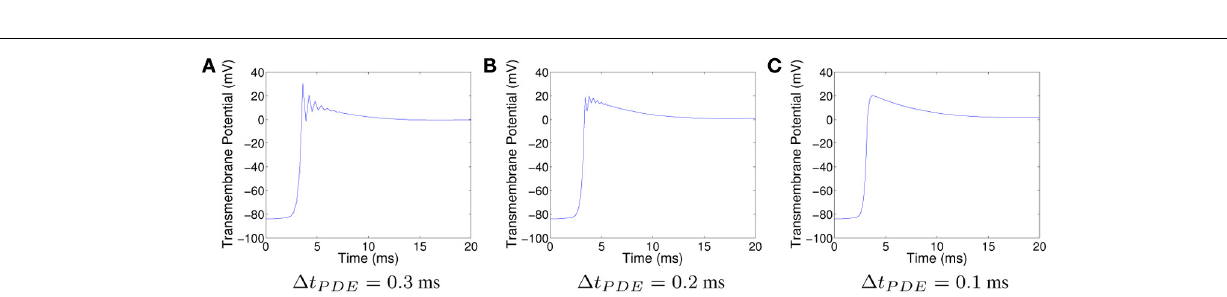
FIGURE 3 | Plots of the transmembrane potential at the spatial point (0.125, 0.125) and t ∈ [0, 20]ms for Scenario I using CN and: (A) = 0 . 3 ms, (B) (cid:3) t = 0 . 2 ms, and (C) (cid:3) t = 0 . (cid:3) t PDE PDE PDE